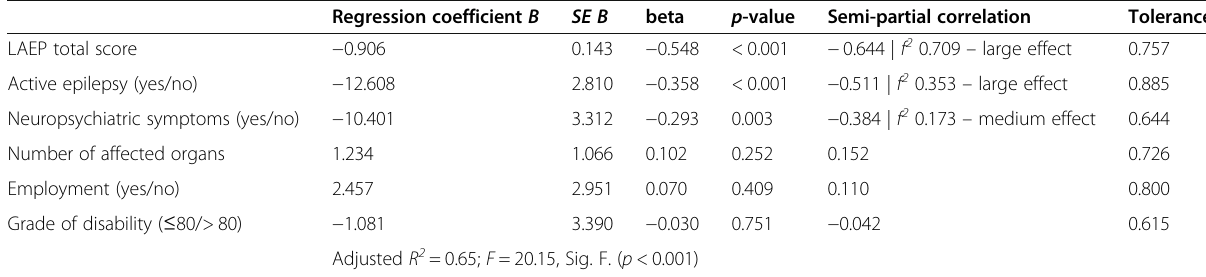
Table 5 Multiple linear regression analyses evaluating potential TSC-related predictors of health-related quality of life (QOLIE-31 overall score) Regression coefficient B SE B beta p -value Semi-partial correlation Tolerance LAEP total score − 0.906 0.143 − 0.548 < 0.001 − 0.644 | f 2 0.709 – large effect 0.757 Active epilepsy (yes/no) − 12.608 2.810 − 0.358 < 0.001 − 0.511 | f 2 0.353 – large effect 0.885 Neuropsychiatric symptoms (yes/no) − 10.401 3.312 − 0.293 0.003 − 0.384 | f 2 0.173 – medium effect 0.644 Number of affected organs 1.234 1.066 0.102 0.252 0.152 0.726 Employment (yes/no) 2.457 2.951 0.070 0.409 0.110 0.800 Grade of disability ( ≤ 80/> 80) − 1.081 3.390 − 0.030 0.751 − 0.042 0.615 Adjusted R 2 = 0.65; F = 20.15, Sig. F. ( p < 0.001) Variables are ordered according to the standardised B (beta) values, in descending order LAEP Liverpool Adverse Events Profile , SE standard error. Effect sizes were calculated from the semi-partial correlation as r 2 part / (1 − r 2 part ). Tolerance was used as a measure of predictor multicollinearity, with tolerance values above a threshold of 0.25 indicating no